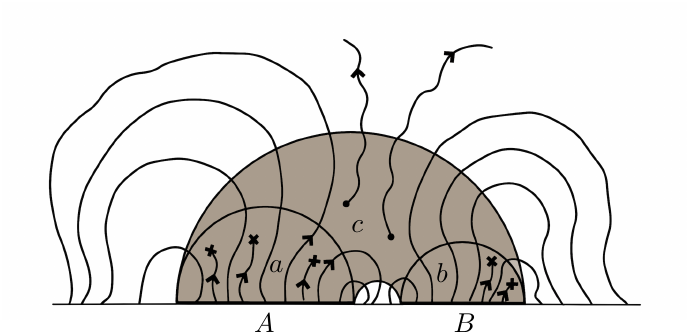
Figure 4 . Thread representation of the max flow associated to a boundary region made out of two simply connected parts A and B . In this case, the entropy density on c = ab \ a ∪ b is negative and thus acts as sources for the quantum threads. When restricted to the region ab , though, some of these threads (the ones starting on c ) are interpreted as classical because they contribute exclusively to the area ∂ ( a ∪ b )